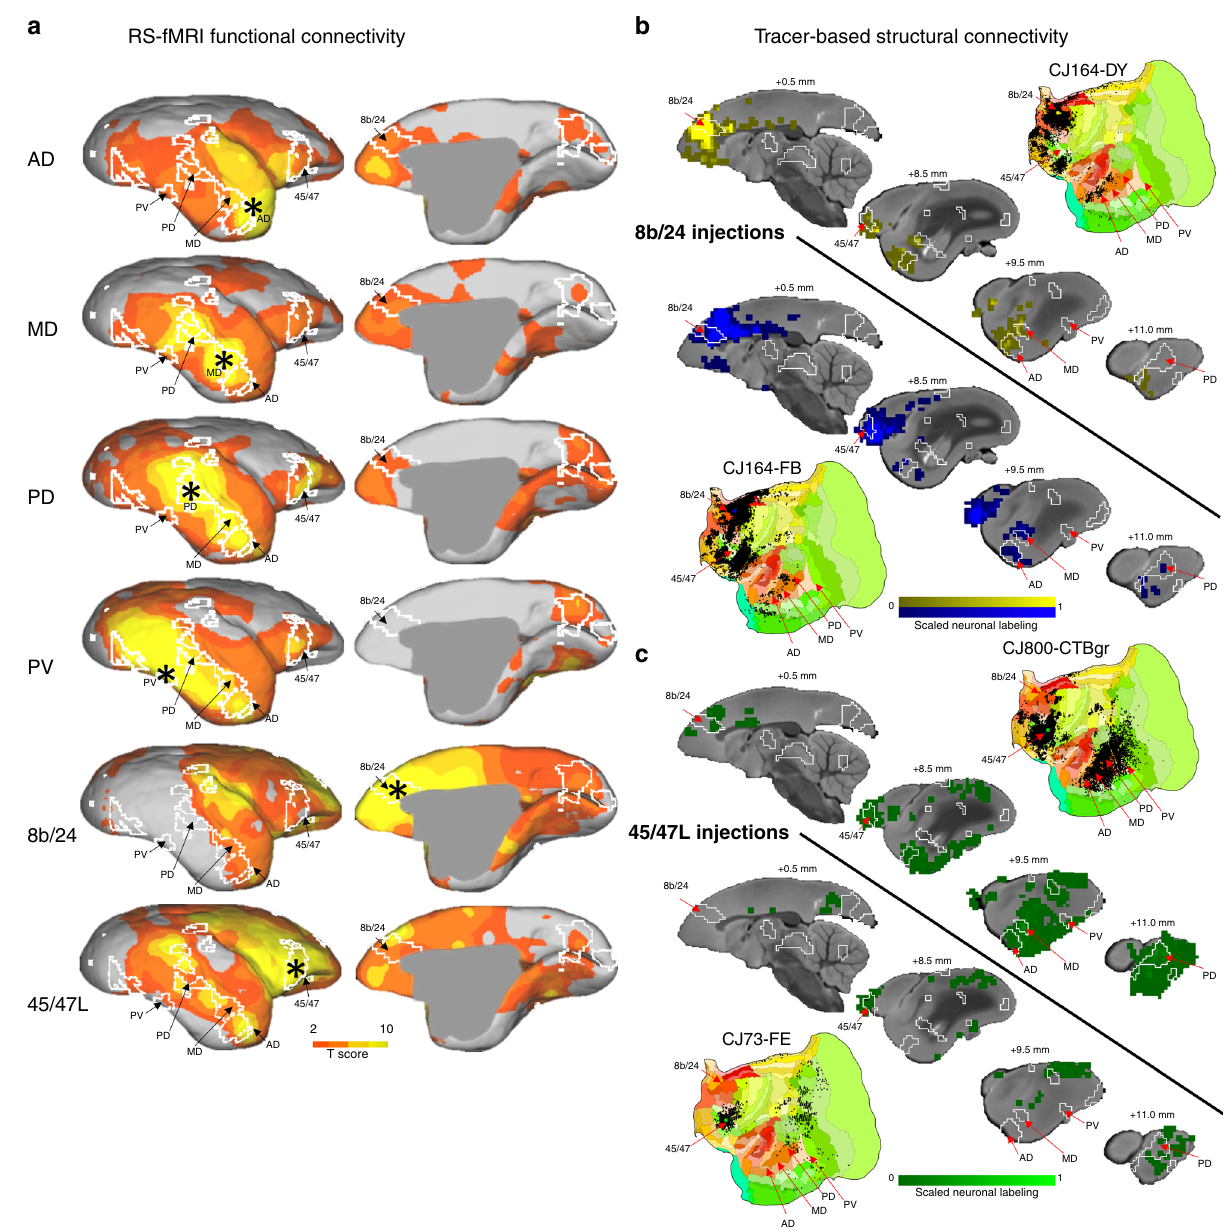
Fig. 3 Functional and structural connectivity of marmoset face patches. a shows RS-fMRI based functional connectivity of four temporal and two frontal face patches with the rest of the brain. b shows the results of retrograde tracer injections, which were proximal to our anterior cingulate cortex face patch. c shows the results of retrograde tracer injections, which were proximal to our 45/47 L face patch. Surface fl at map representations of these tracer injections (downloaded from marmosetbrain.org) are also shown. In all panels a – c white lines show the functional clusters found by comparing the directed and averted-gaze conditions for reference (i.e., the topology shown in Fig.